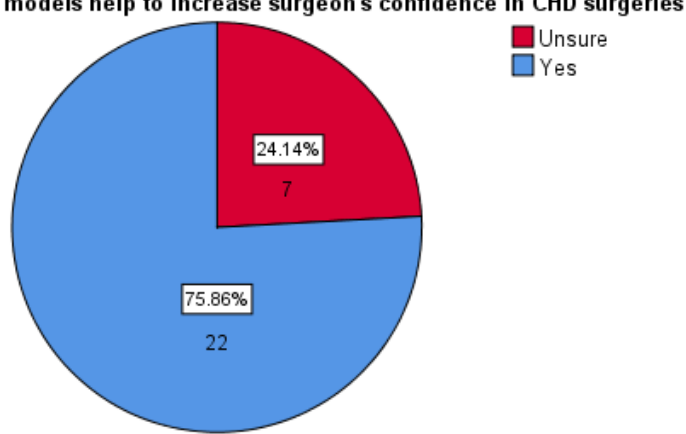
Figure 4. Responses from the participants with regard to their opinion on whether VR and 3DPHM help to increase surgeons’ confidence in CHD surgeries.